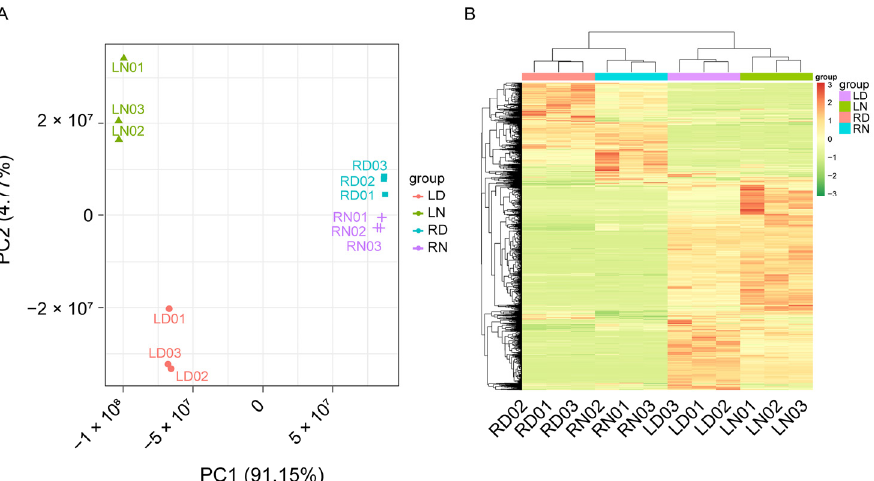
Figure 4. Principal component analysis ( A ) and hierarchical clustering results ( B ) using all detected metabolite changes in ‘Pujiang Xiangcheng’ leaves and roots with HLB infection. LD: leaf with HLB disease; LN: healthy leaf tissue; RD: root with HLB disease; RN: normal healthy root tissue.